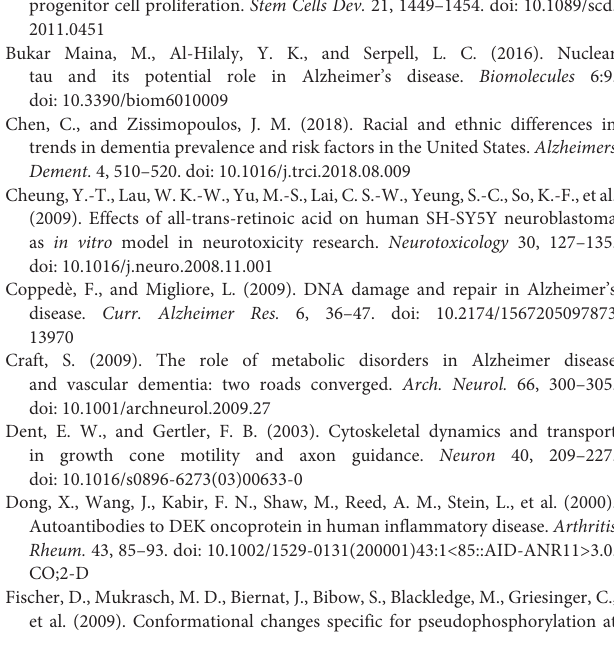
SUPPLEMENTARY FIGURE 1 | Sites AT180 and AT8 of Tau are not abnormally phosphorylated in DEKsh cells. (A–C) DEKsh leads to increased unphosphorylated Tau (Tau-1 antibody) protein expression, quantified via Western blot ( A,B ; ** p < 0.01) and immunofluorescence (C) . (D) Representative immunofluorescence images demonstrate increased unphosphorylated Tau (Tau-1) in DEKsh cells. Representative images of phosphorylated Tau at sites AT180 and AT8. (E) Fluorescent intensity analysis reveals no significant difference in Tau phosphorylation at AT180 or AT8 in DEKsh